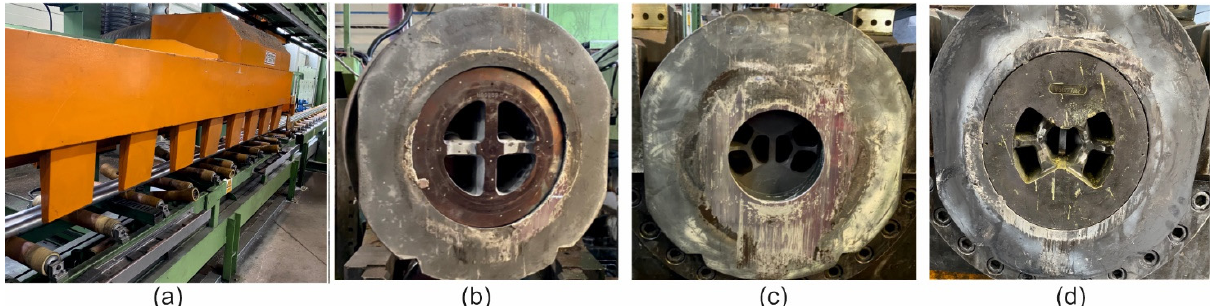
Figure 4. The 25 MN 7 inch extrusion press run-out table ( a ) and different extrusion porthole dies: extrusion die 1 ( b ), extrusion die 2 ( c ) and extrusion die 3 ( d )—designed for 2-hole extrusion tests of tubes of Ø50 × 2 mm from 7021 alloy in industrial conditions.